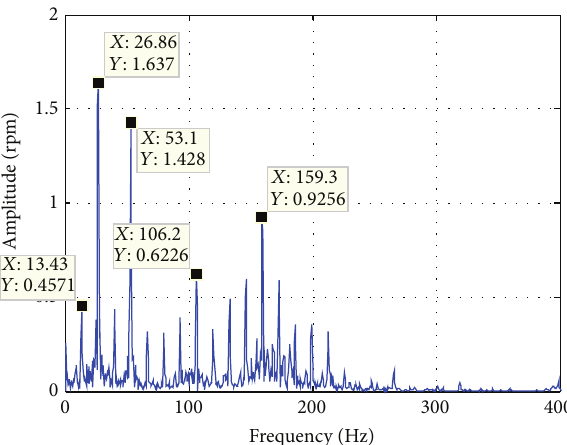
Figure 24: Angular acceleration of the engine.